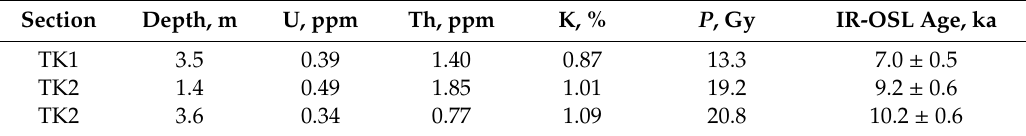
Table 4. IR-OSL results and radioactivity data for the samples from sections TK1 and